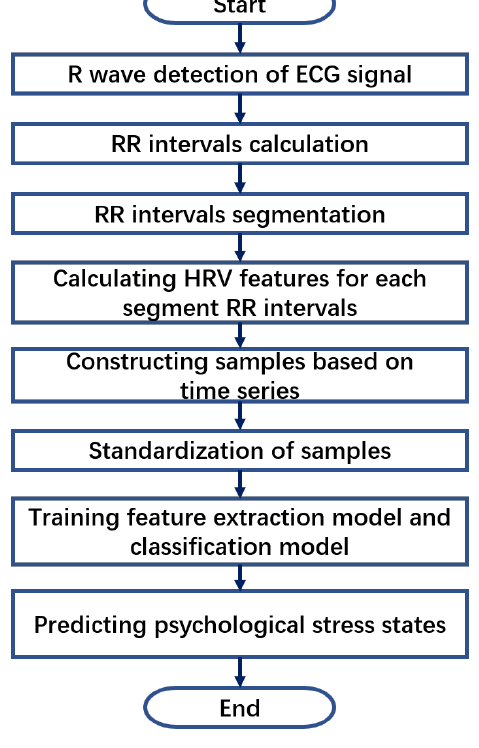
Figure 5. The flow chart of the proposed method.